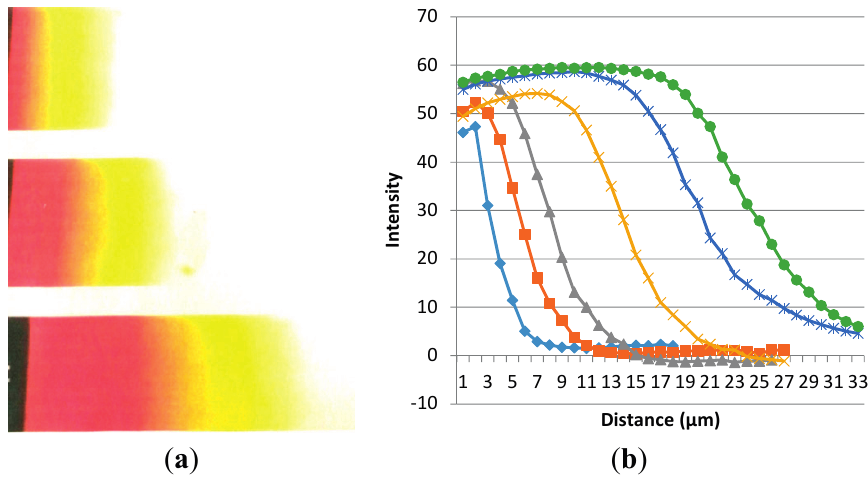
Figure 7. ( a ) PAT diffusion profiles into EVA layers at different time intervals; ( b ) The diffusion frontier moves with time. Curves from left to right are for 30, 45, 75, 122, 180, and 240 min. The temperature for this experiment was 140 °C and the magnification of the optical microscope picture is 100×.